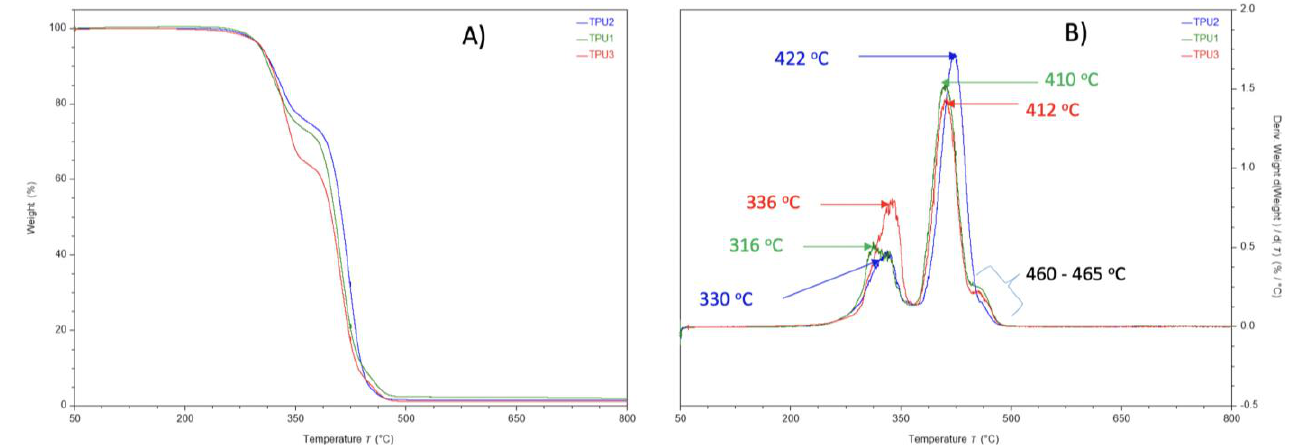
Figure 7. ( A ) TGA analysis and ( B ) DTG curve of TPUs under nitrogen atmosphere.